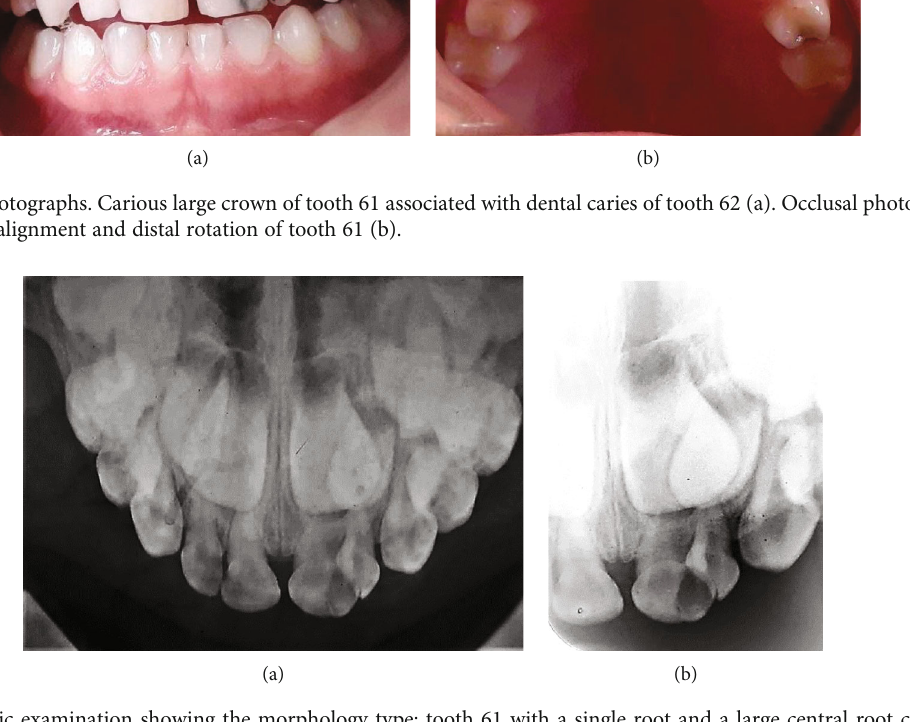
Figure 2: Radiographic examination showing the morphology type: tooth 61 with a single root and a large central root canal. Periapical radiograph (a). Maxillary occlusal radiograph